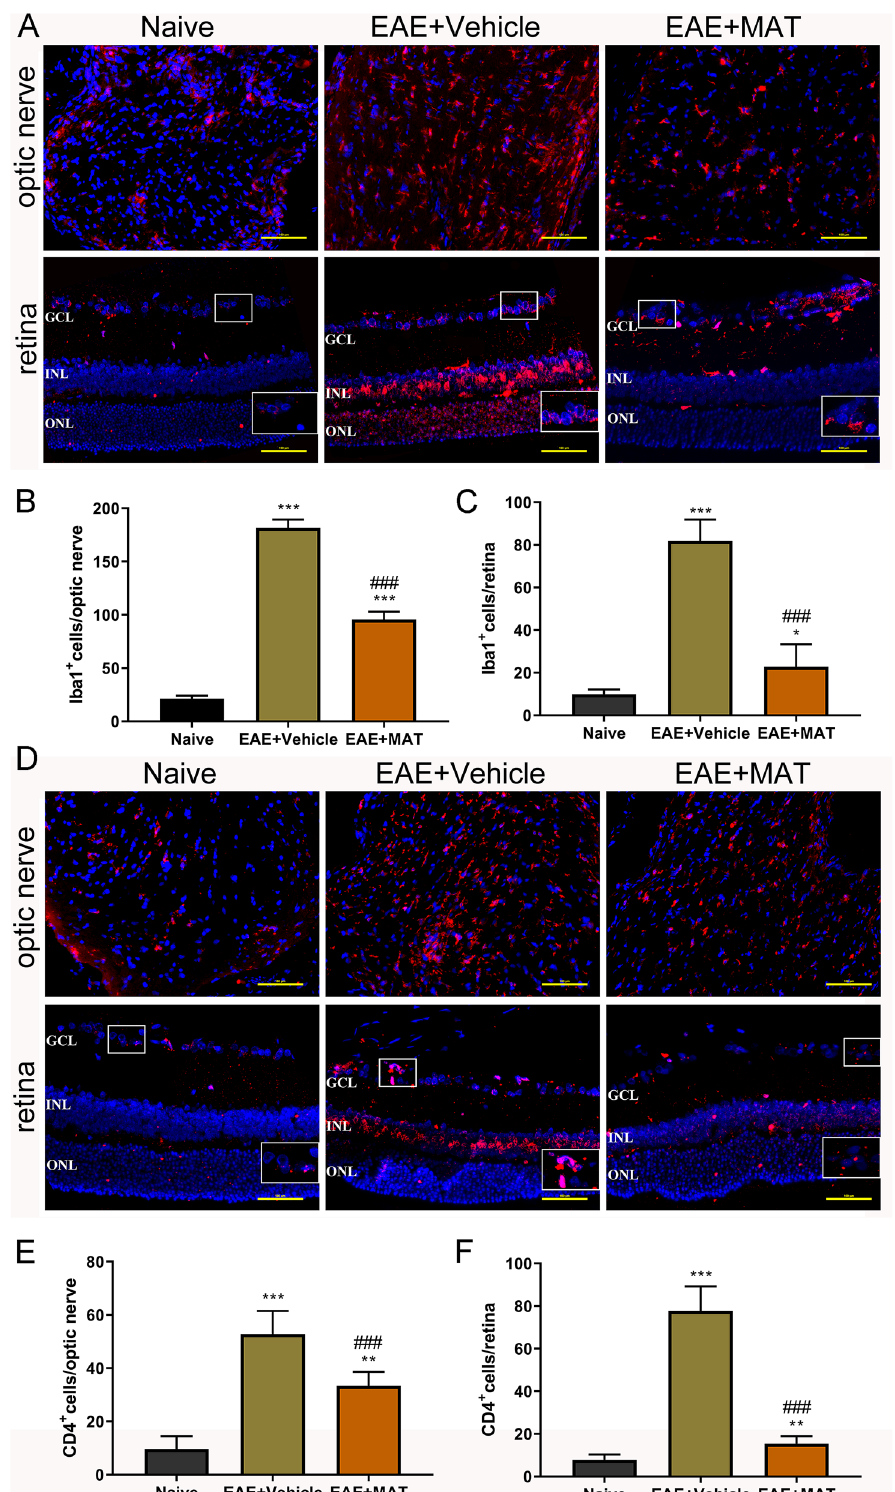
Figure 3. MAT treatment reduced numbers of Iba1 + and CD4 + cells in the optic nerve and the retina. Both sides of optic nerves and the retina were harvested from rats described in Fig. 1 at day 18 p.i. Immunofluorescence staining for Iba1 ( A , red) and CD4 ( D , red) in optic nerve and the retina sections. Scale bars = 100 µm. ( B ) and ( C ) Quantitative analysis of the number of Iba1 + cells in the optic nerve and retina, and ( E ) and ( F ) quantitative analysis of the number of CD4 + cells in the optic nerve and retina. ONL, outer nuclear layer; INL: inner nuclear layer; GCL, ganglion cell layer. Data are expressed as mean ± SD (n = 20 optic nerves and the retinas from 10 rats per group). Multiple comparisons were performed using one-way ANOVA, followed by Student–Newman–Keuls test. * P < 0.05, ** P < 0.01, *** P < 0.001, comparison with the naive group. ### P < 0.001, comparisons between vehicle- and MAT-treated